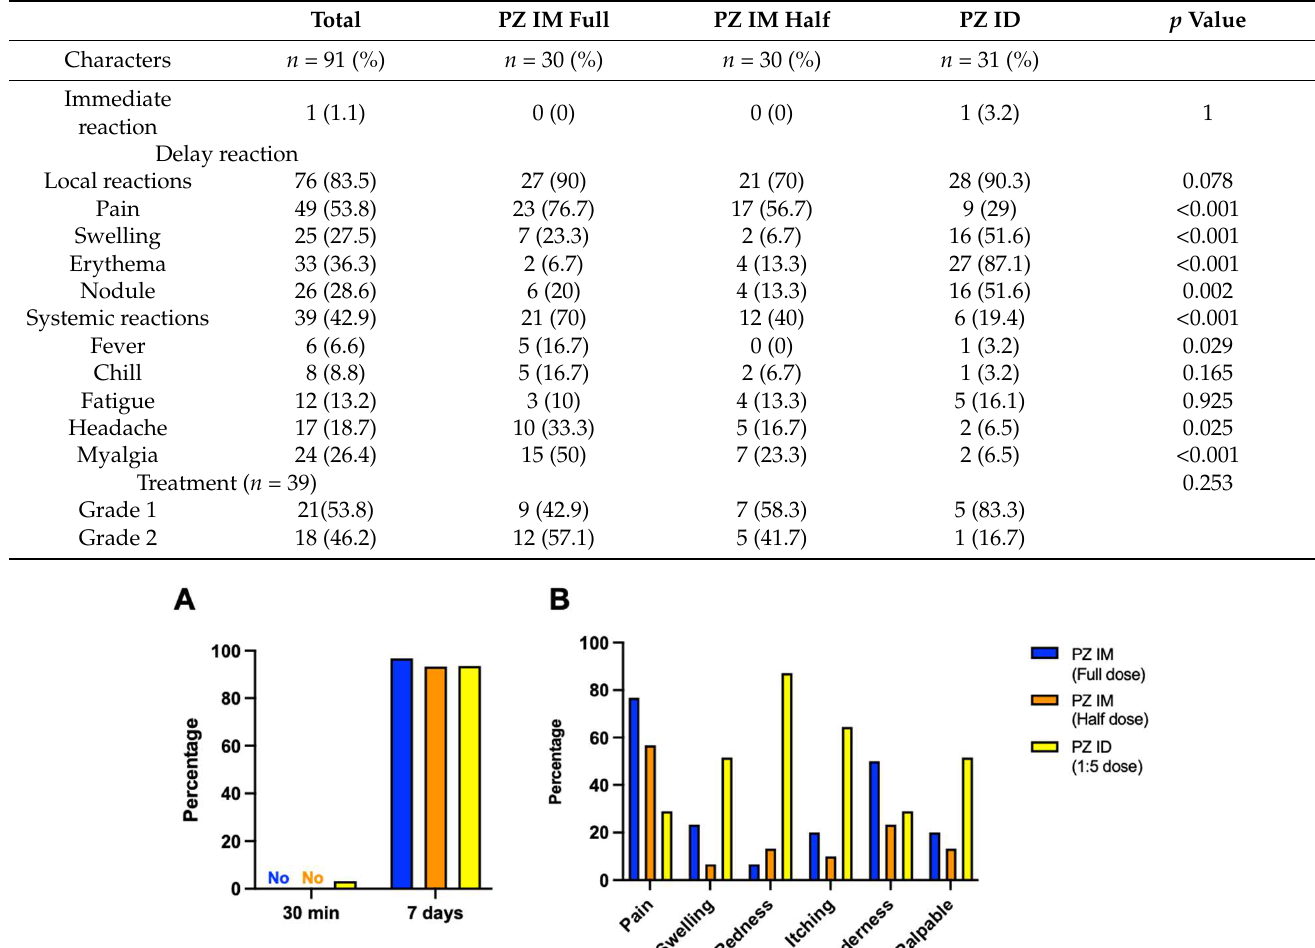
Table 2. Adverse events of the intramuscular (IM) and intradermal (ID) boosting, with BNT162b2 (PZ) in the healthy, general population.